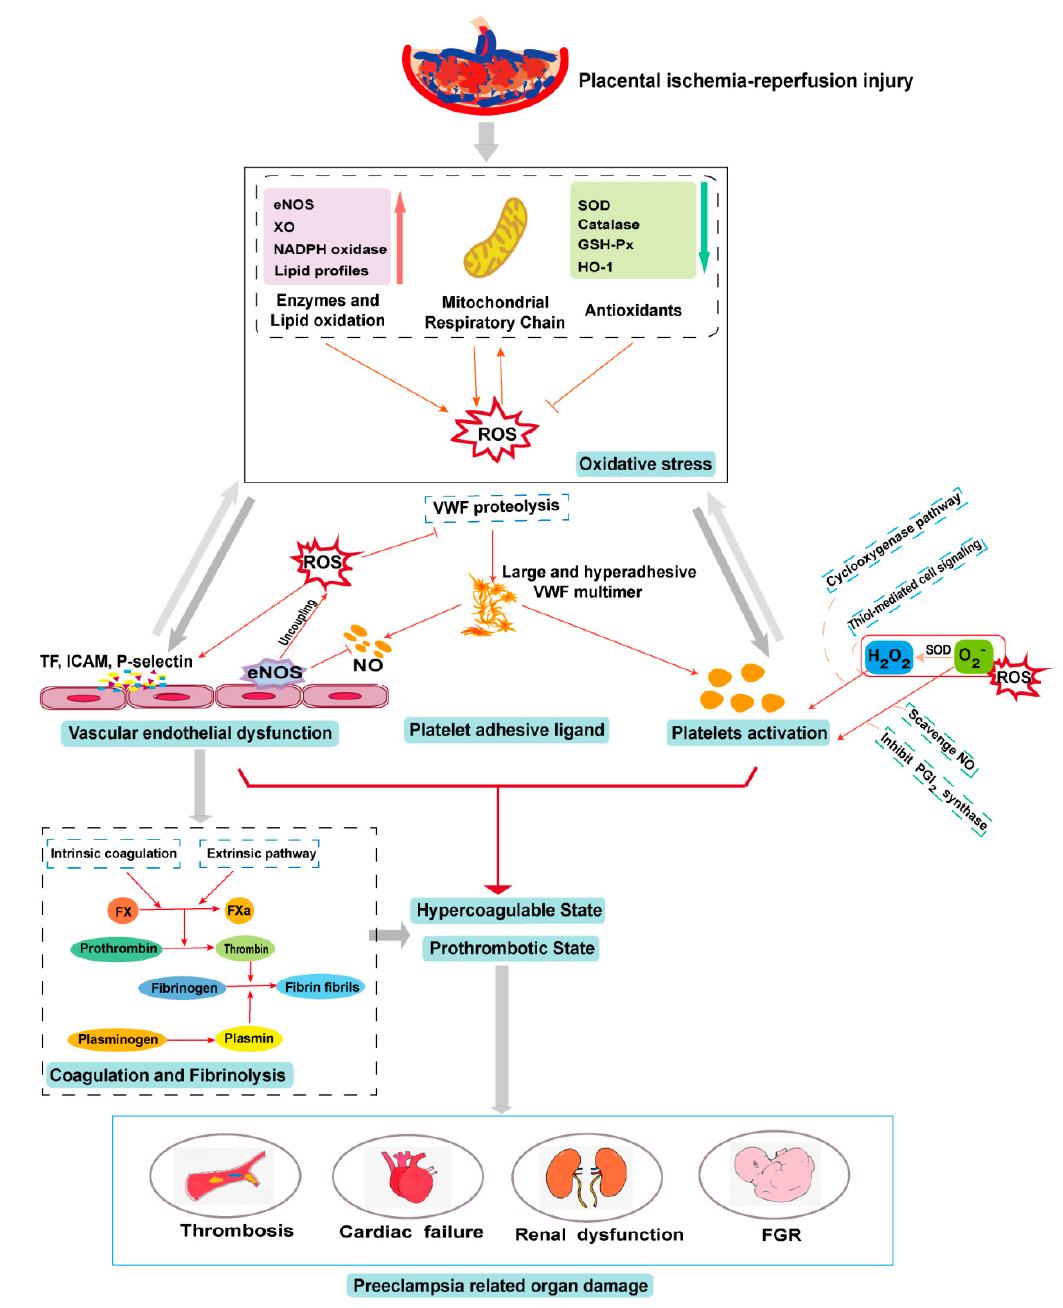
Figure 2. Pathogenesis of the preeclampsia (PE)-associated prothrombotic state. Placental ischemia–reperfusion injury induces mitochondrial dysfunction and oxidative stress and reduces the antioxidative defense, producing excessive reactive oxygen species (ROS). This oxidative stress propagates placental injury and also disseminates to systemic circulation, where it injures endothelial cells and activates platelets to express procoagulant activities and to produce prothrombotic and proinflammatory extracellular vesicles. The procoagulant cells and molecules initiate and propagate the hypercoagulable and prothrombotic states that result in arterial and venous thrombosis, renal dysfunction, and fetal growth restriction (FGR). eNOS: endothelial nitric oxide synthase; XO: xanthine oxidase; SOD: superoxide dismutase; GSH-Px: glutathione peroxidase; HO-1: heme oxygenase-1; TF: tissue factor; ICAM: Intercellular Adhesion Molecule; NO: nitric oxide; PGI 2 : Prostaglandin I 2 .